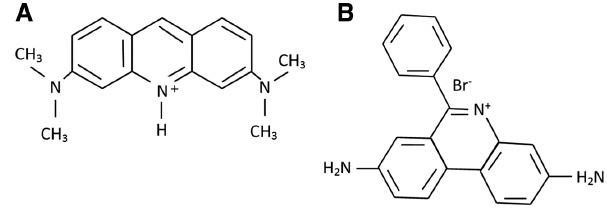
Figure 14 (A) Structure of acridine orange and (B) structure of ethidium bromide.